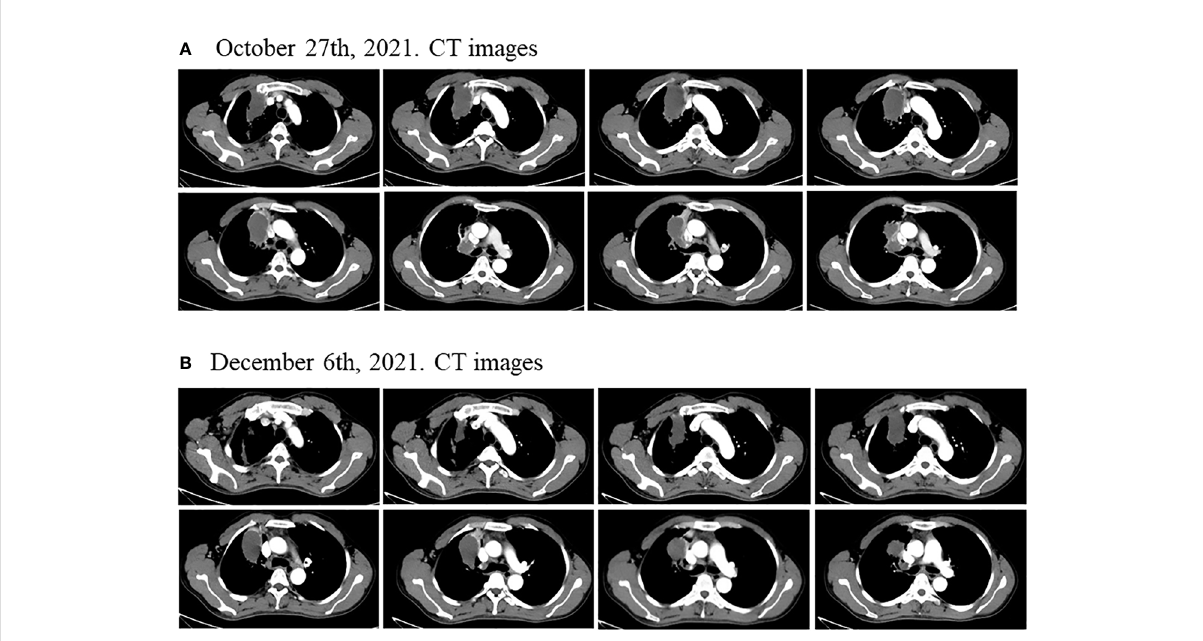
FIGURE 2 Disease status after neoadjuvant chemotherapy plus immunotherapy and chemotherapy plus EGFR-TKI. (A) After two cycles of neoadjuvant chemotherapy plus immunotherapy, the size of the lung fi eld from the right hilum to the right upper lobe of the lung large cystic solid mass was 6.6 × 4.6 × 6.0 cm. (B) After one cycle of neoadjuvant chemotherapy plus EGFR-TKI, the size of the lung fi eld from the right hilum to the right upper lobe of the lung large cystic solid mass was 6.2 × 3.5 × 5.5